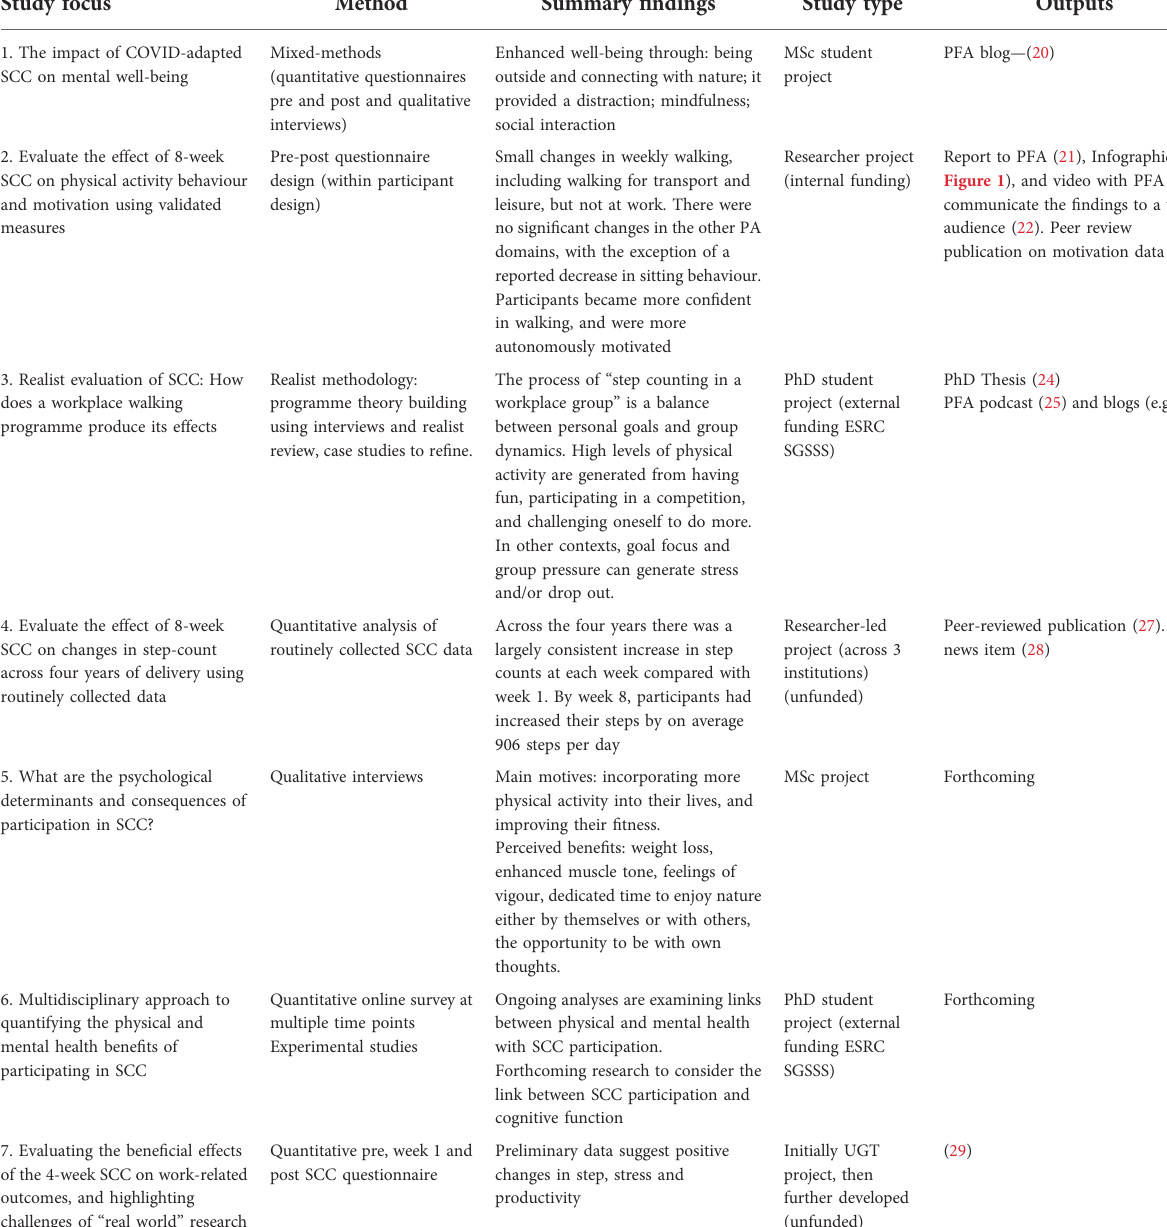
TABLE 1 Example research studies undertaken by the